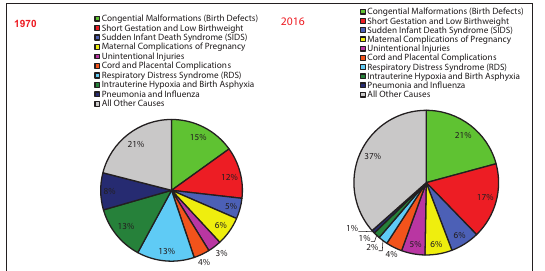
Congential Malformations (Birth Defects) Short Gestation and Low Birthweight Sudden Infant Death Syndrome (SIDS) Maternal Complications of Pregnancy Unintentional Injuries Cord and Placental Complications Respiratory Distress Syndrome (RDS) Intrauterine Hypoxia and Birth Asphyxia Pneumonia and Influenza All Other Causes